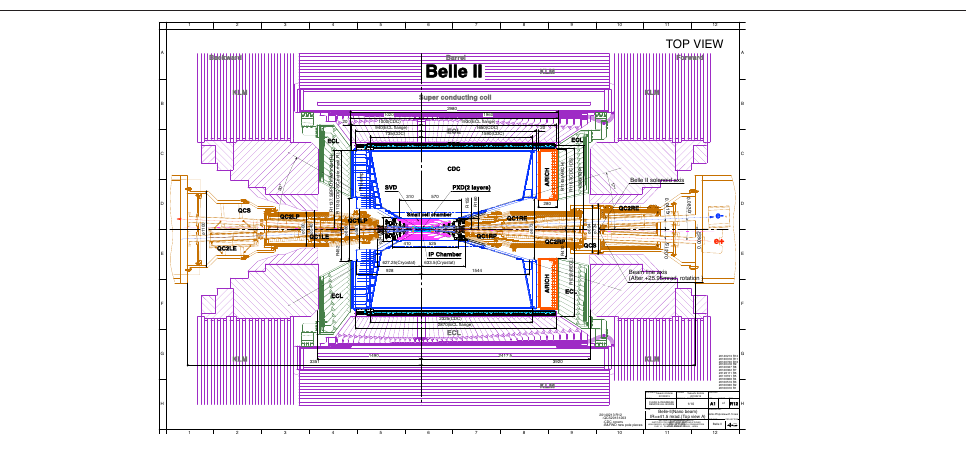
Figure 1. Cut view of the Belle II detector in the r − z plane